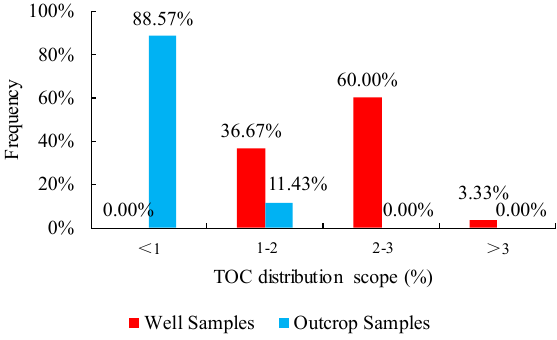
Figure 4. Carbon isotope variation of Xinkailing-formation shale samples in Wuning.